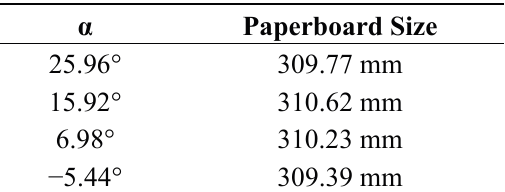
Table 6. Average values of the measured size of the square paperboard under analysis. The target has a nominal dimension of 310